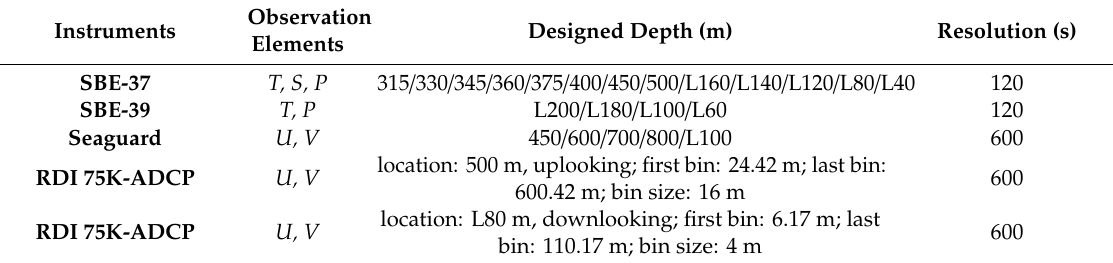
Figure A1. Design of buoy and mooring at Station 1. Table A1. Observation instruments and measured elements at Mooring 1